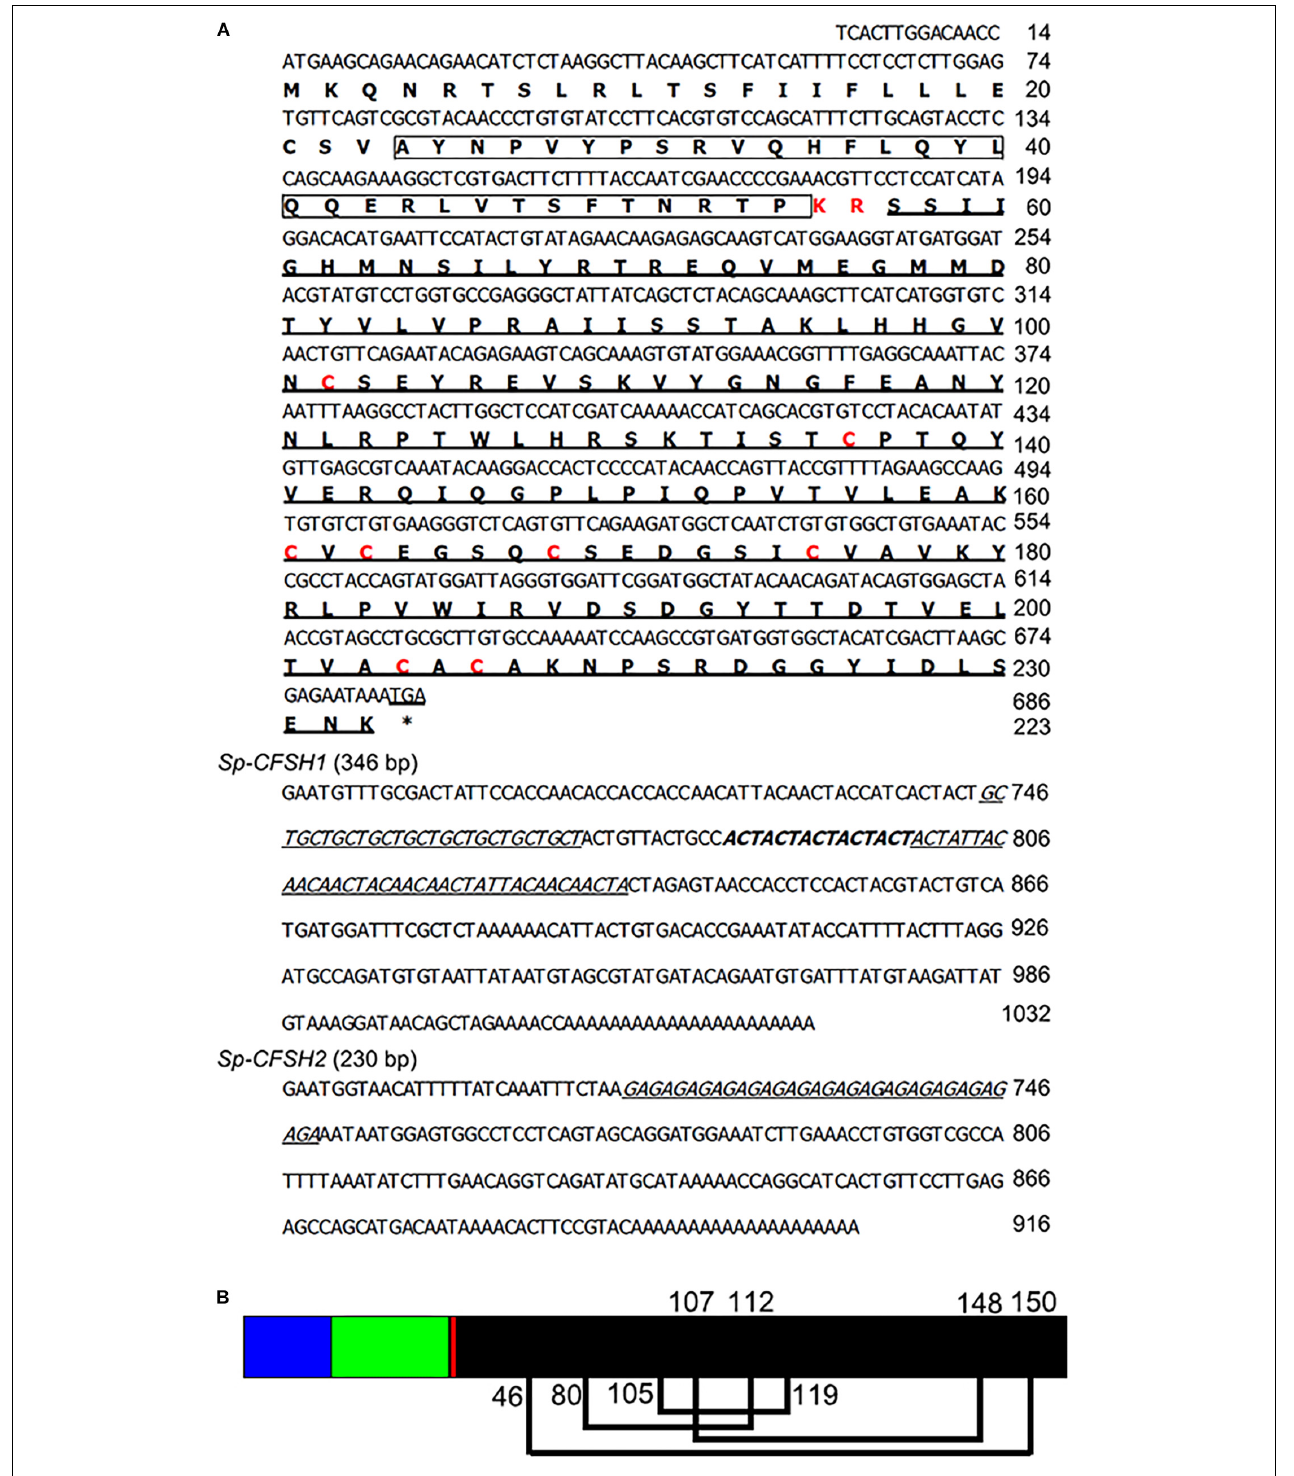
FIGURE 1 | (A) The nucleotide and deduced amino acid sequence of Sp-CFSH1 and Sp-CFSH2 from the mud crab S. paramamosain . The ORF is shown in a single letter code below the nucleotide sequence. The CFSH precursor-related peptide is boxed, the dibasic cleavage site (KR) and eight cysteine residues are indicated in red. The mature peptide and the microsatellites in the 3 (cid:48) -UTR are underlined. (B) A schematic diagram of prepro-CFSH. Signal peptide (blue bar), CFSH precursor-related peptide (green bar), a dibasic cleavage site KR (red bar), and the mature hormone (black bar). The eight cysteine residues are predicted to form four putative disulfide bridges connected with lines (C46-150, C80-112, C105-119, and C107-148).